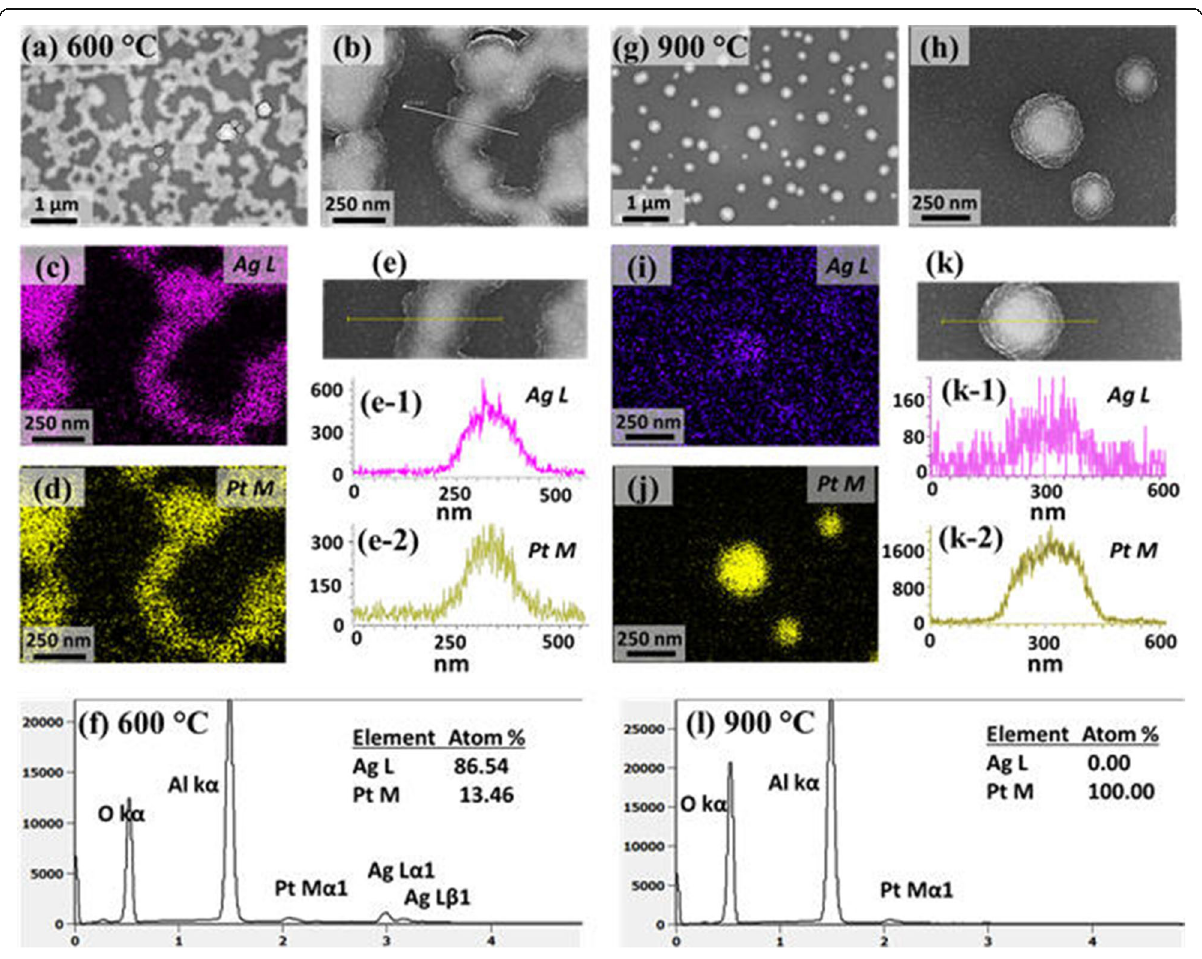
Fig. 6 Elemental analysis of the typical AgPt and Pt NPs fabricated with the Ag21nm/Pt4.5 nm bilayers at 600 and 900 °C for 120 s. a, b SEM images of AgPt alloy nanoclusters. c , d Elemental phase map of Ag L and Pt M. e – ( e-2 ) Elemental line profiles of Ag and Pt through the nanocluster. f EDS spectra of the AgPt alloy nanoclusters at 600 °C. g , h SEM images of Pt NPs. i , j Elemental phase maps. k – ( k-2 ) EDS line profile through the typical Pt NP. l EDS spectra of Pt NPs at 900 °C. The EDS map, line profile, and spectra show the absence of Ag in the NPs at 900